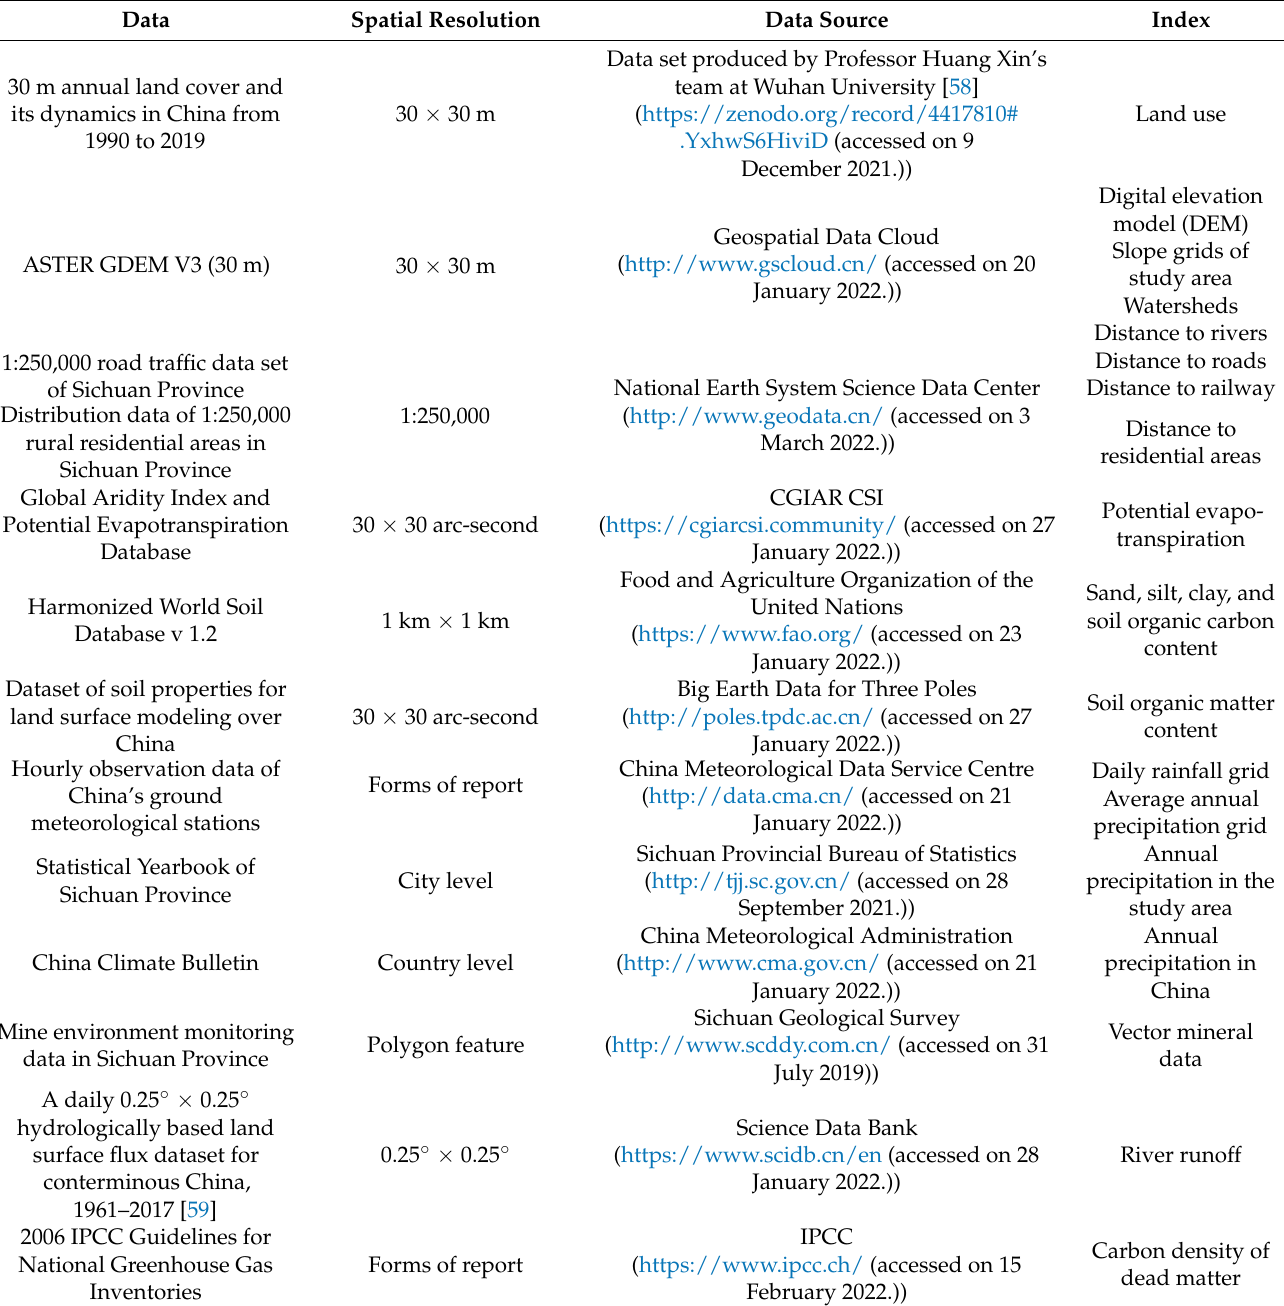
Table 1. Data information and data